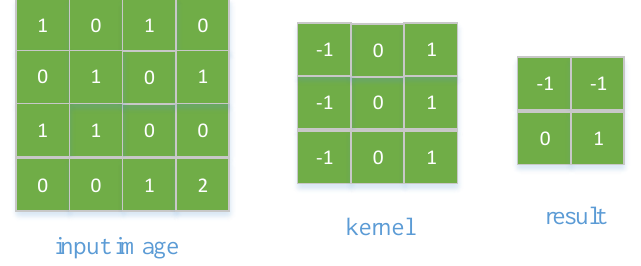
Figure 2. Convolution